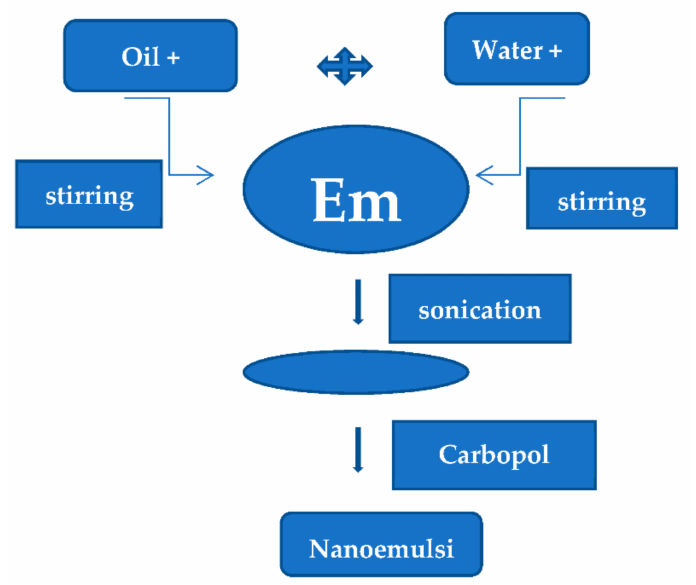
Figure 1. Preparation of nanoemulsion in situ gel by the ultra-sonication method. Different concentrations of emulsifying agents and gelling agents were used in trial batches and studied to have a sustaining effect for 24 h. In all batches, the concentration of drug and oil were kept constant; the data are presented in Table